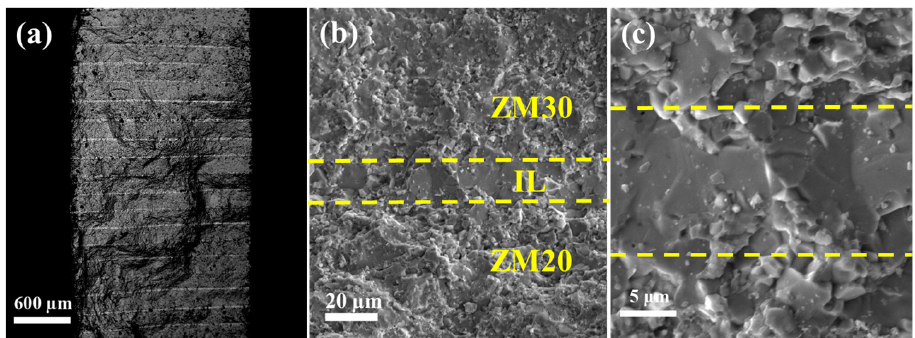
Figure 7. SEM images of the overall cross-section ( a ) the selected area including the matrix layer and the interlayer ( b ) and higher magnification of the selected area ( c ) of the laminated ceramic with the layer thickness ratio of 13.